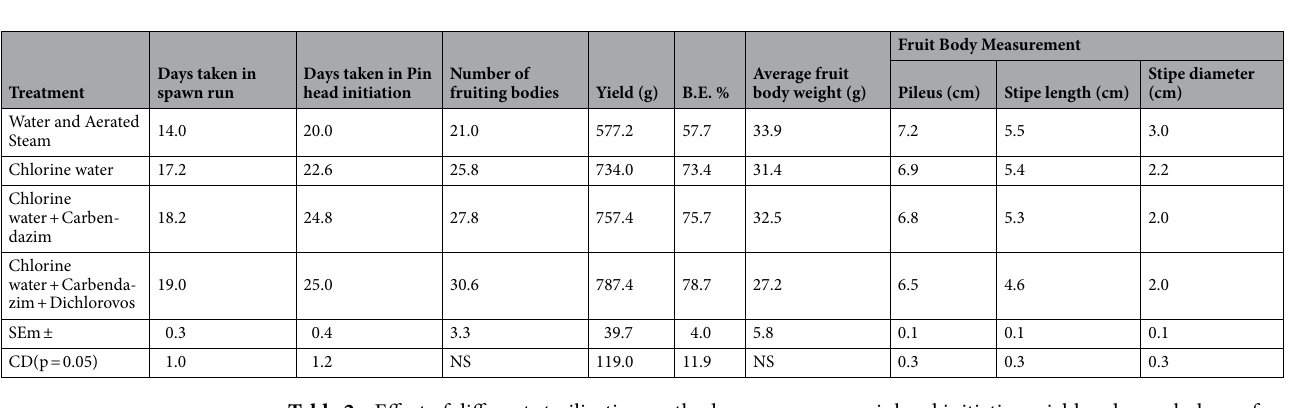
Table 2. Effect of different sterilization methods on spawn run, pinhead initiation, yield and morphology of Pleurotus eryngii. SEm ± : Standard error of the mean. CD(p = 0.05) : Critical difference. All the observations are average of five replications.